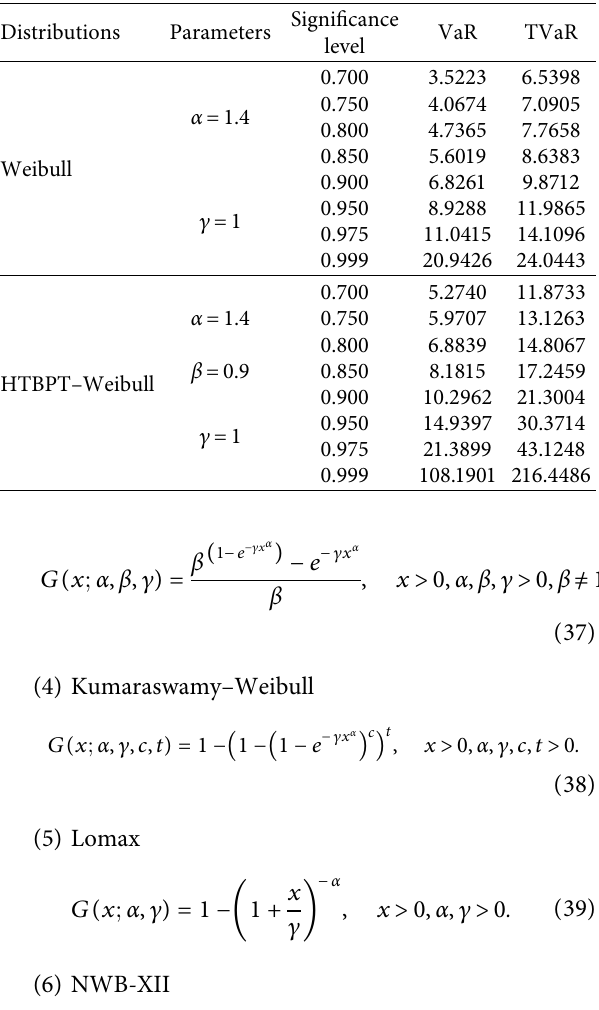
Table 4: For n � 100, the simulation study of the risk measures for Weibull and HTBPT–Weibull distributions.